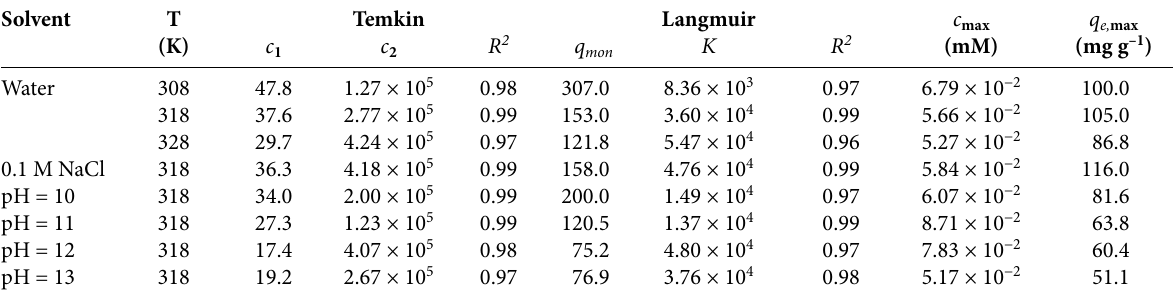
Table 3. Parameters obtained from the Temkin and Langmuir equations and c max and q e, max values for adsorption of CR on Mg-Al-LDH nano- compound in section IIB (on 003 site) in water, 0.1 M NaCl and alkaline solutions at 308–328 K. Solvent